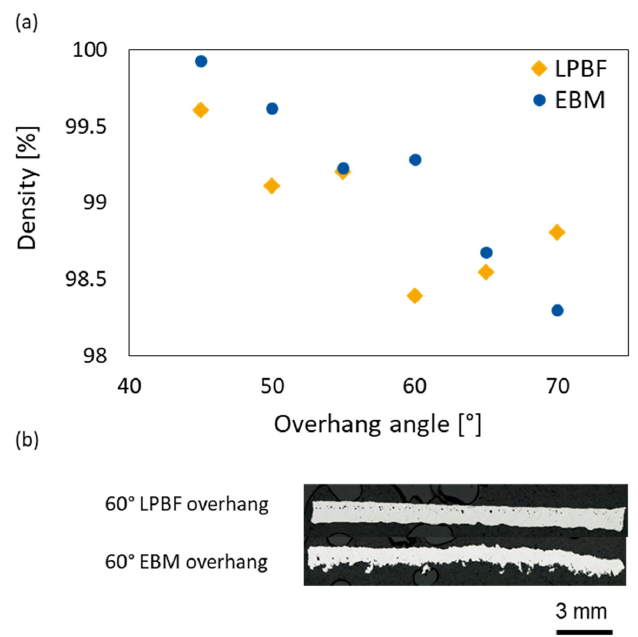
Figure 4. Cross-sections of LPBF and EBM samples.